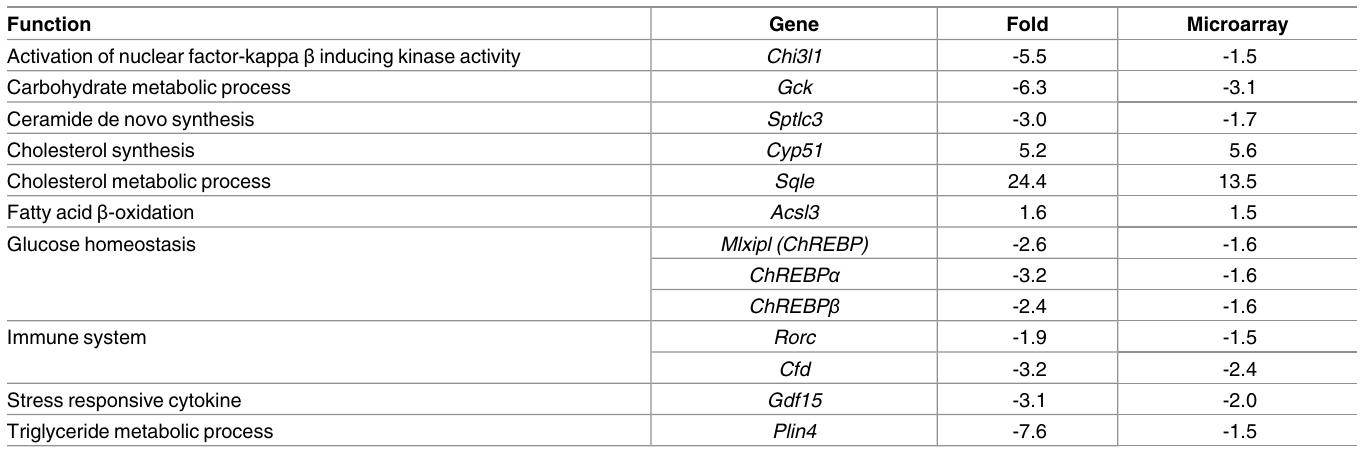
Table 5. RT-PCR validation of selected genes from microarray